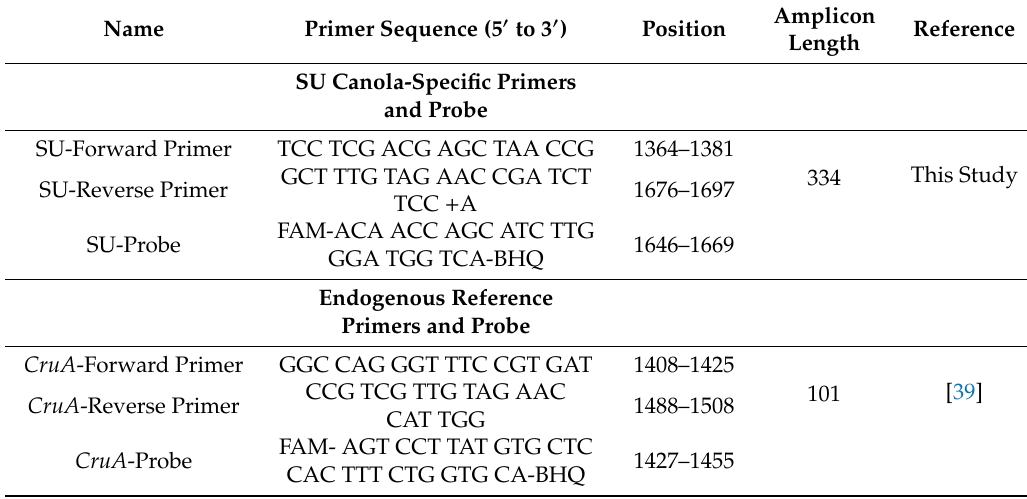
Table 1. Sequences of primers and probes used. + A denotes the locked nucleic acid (LNA) version of A; FAM, 6-carboxyfluorescein; -BHQ, Black Hole